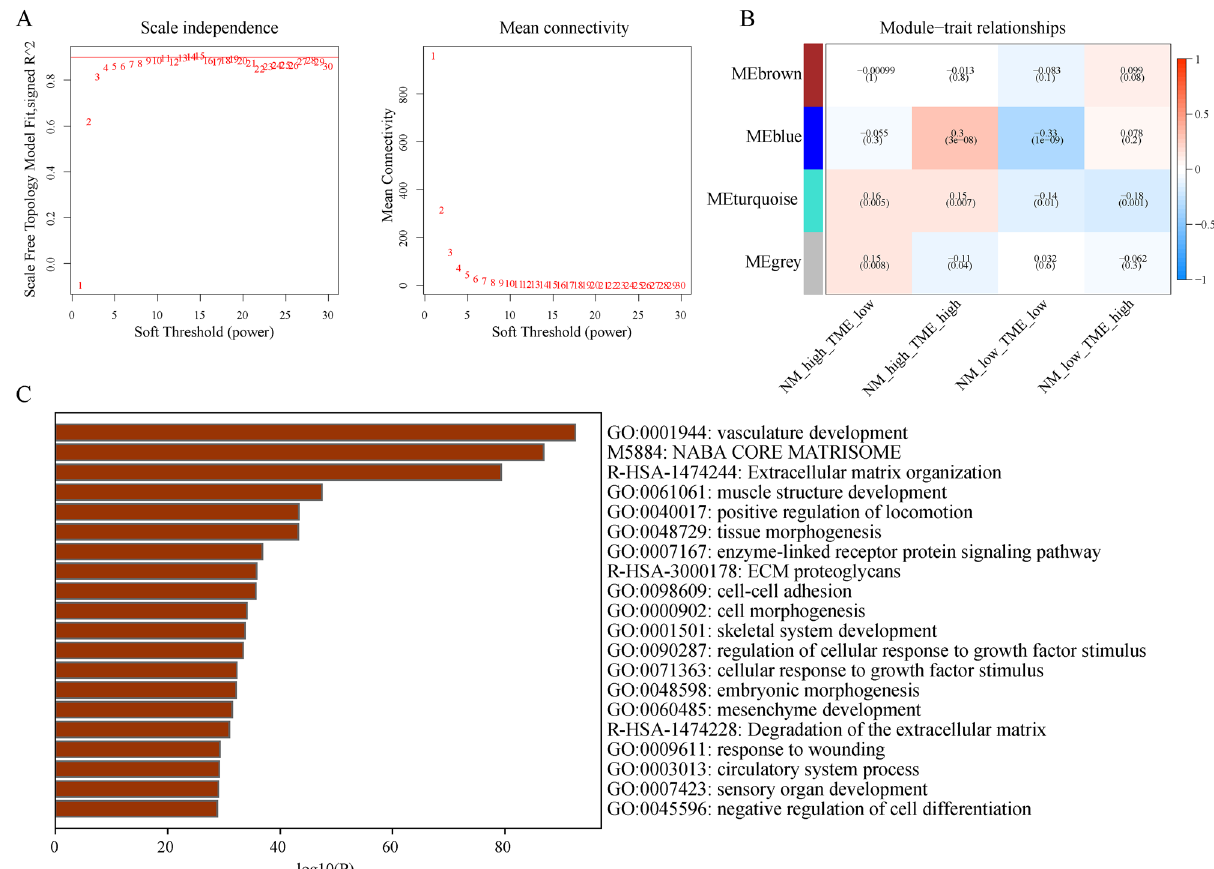
Figure 5. Exploring key module eigengenes associated with the NMlow/TMEhigh and NMlow/TMElow groups using weighted gene co-expression network analysis. ( A ) Evaluation of the scale-free fit index for differing soft-thresholding powers (β) and examination of the connectivity of various soft-thresholding powers. ( B ) A heatmap depicts the association between module eigengenes and various subgroups. ( C ) Functional enrichment analysis of key module eigengenes. NM nucleotide metabolism, TME tumour